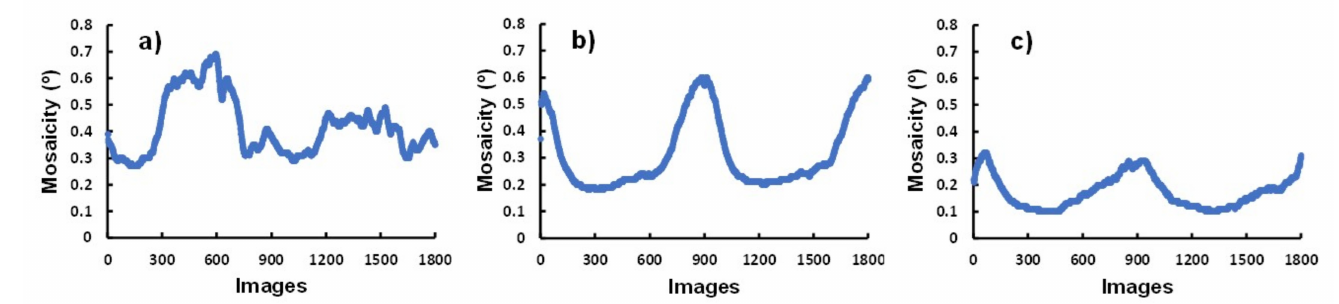
Figure 7. Mosaicities are plotted against the continuous frames: ( a ) 4834BK1 from PEG4000, ( b ) 4835M from PEG10,000 and ( c ) 4836M from